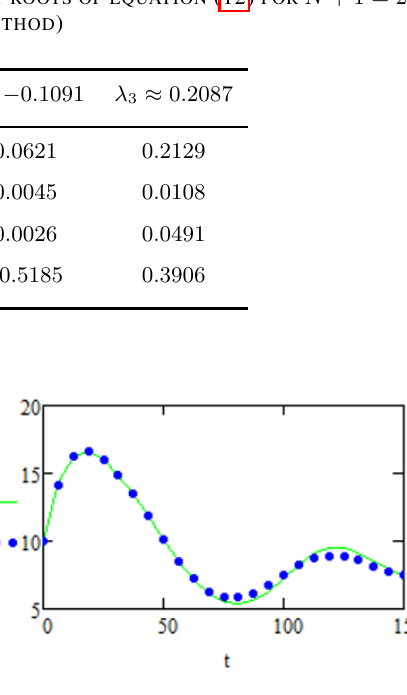
Fig. 3. Graph of original solution x = x ( t ) (dots) and solution with estimated parameters (solid line)